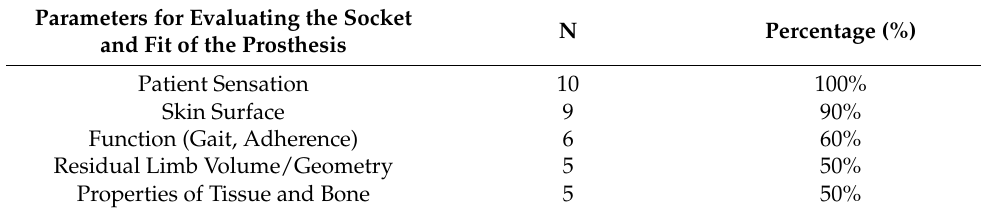
Properties of Tissue and Bone 5